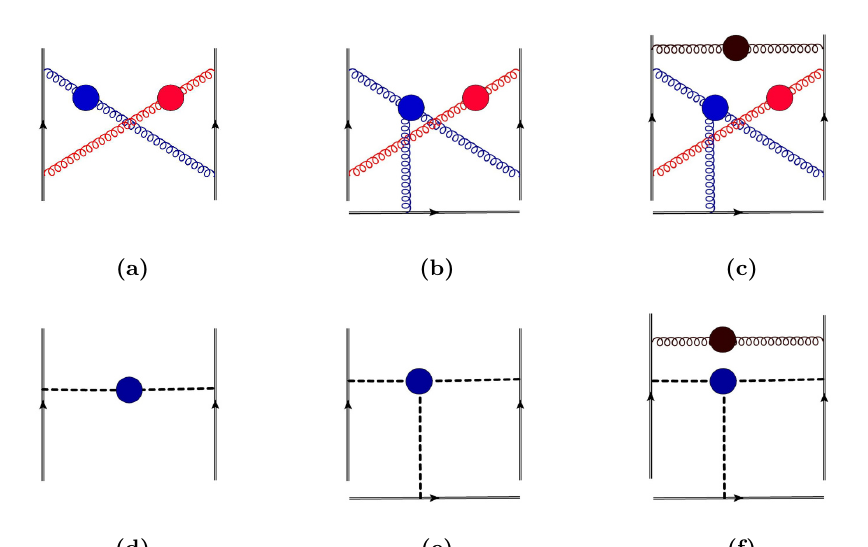
Figure 2. Replacing an entangled piece by n -point correlators. Here, the diagrams in (a), (b) and (c) have an entangled piece made up of the blue and the red gluon correlators involving two and three Wilson lines. Therefore, replacing the entangled piece of diagram (a) with a two point Fused correlator; and that of diagram (b), and (c) with a three point Fused correlator, provides the Fused diagrams (d), (e), and (f) respectively. With this replacement, the diagrams (a), (b), and (c), having s = 0 correspond to Fused diagrams (d), (e), and (f), with s = 1 , respectively. The colour factors of (d), (e) and (f) are same as those of (a), (b) and (c) respectively.